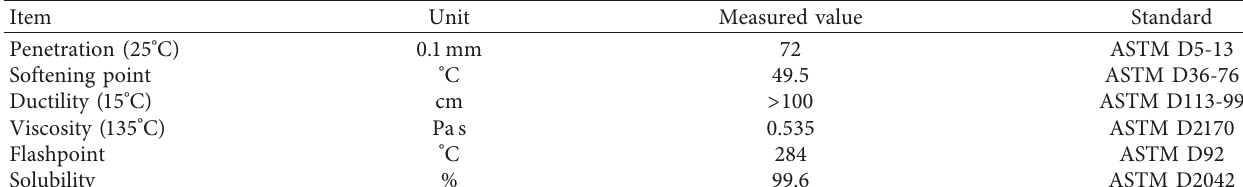
Table 1: Basic properties of the virgin